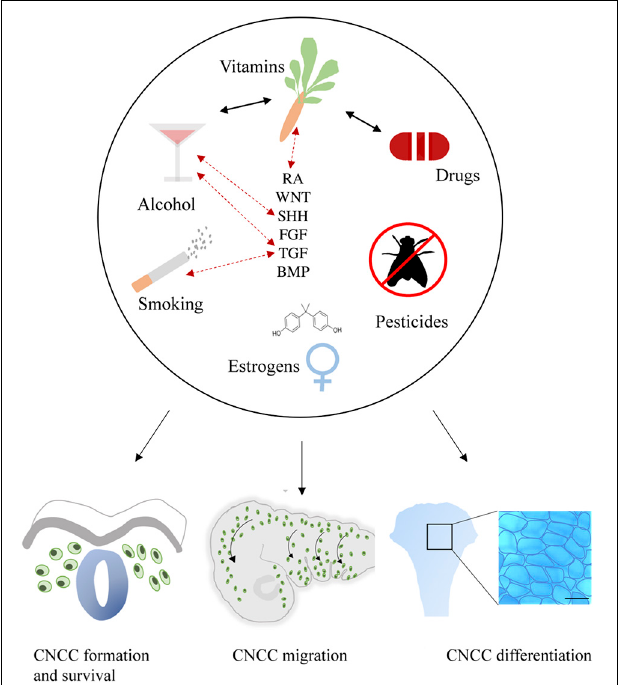
FIGURE 4 | General summary showing the environmental factors smoking, alcohol use, vitamin imbalance, drug use, (xeno) estrogens and pesticides. These factors (represented in the upper part of the figure) differentially affect critical developmental processes such as the formation, survival, delamination, migration, condensation, and differentiation of CNCCs (represented in the lower part of the figure). Evidence of interactions between environmental factors that result in craniofacial malformations has been reported as well, these are indicated by black arrows. Exposure to environmental factors often results in aberrant signaling of essential pathways in craniofacial development including SHH, TGF, FGF, BMP, RA, and WNT. Moreover, gene mutations in these pathways can also interact with environmental factors, complicating the etiology. Known GxE interactions are indicated in this figure with red dotted